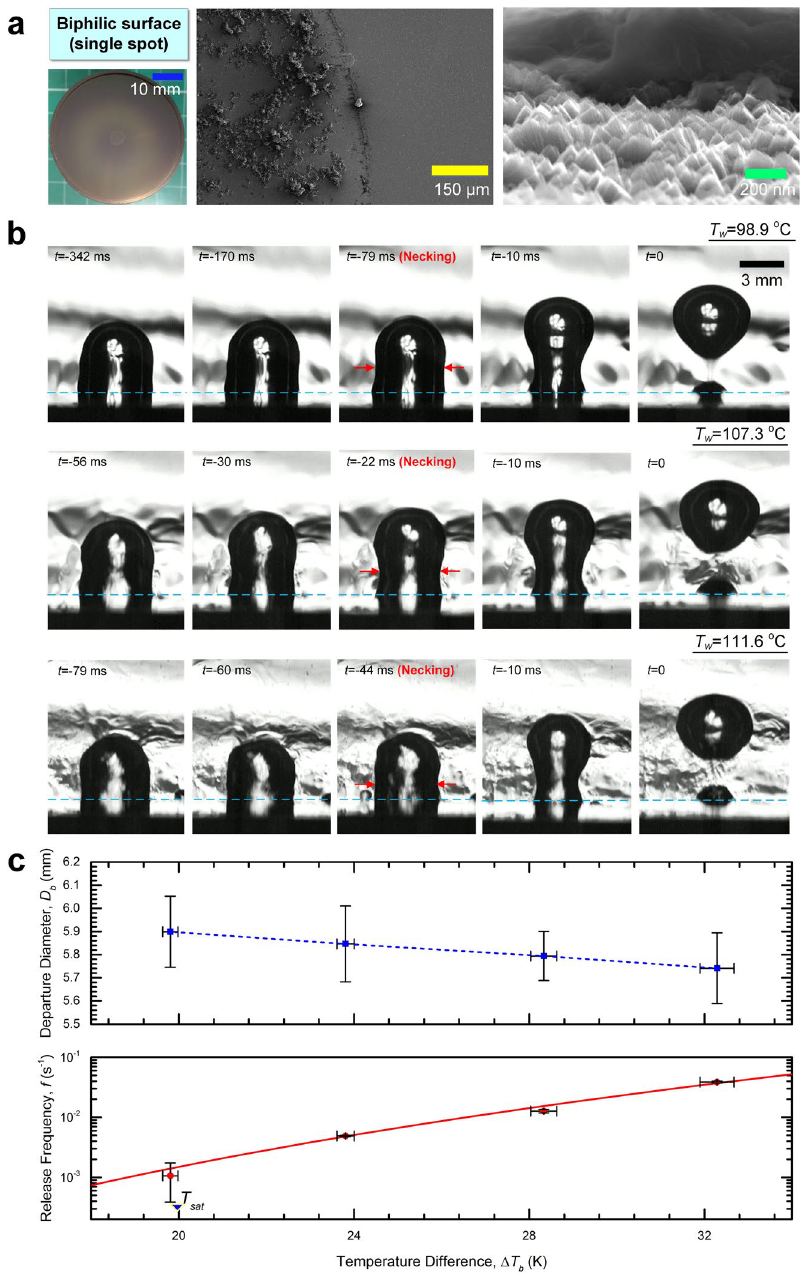
Figure 3. Bubble behaviour in the open system. ( a ) A heterogeneous surface with a single artificial nucleation site. On the superhydrophilic TiO 2 surface ( θ e ≈ 0°, post UV-irradiation) was deposited by drop-coating a hydrophobic island ( θ e > 145°) with a diameter of 6 mm that was composed of APTES (3-aminopropyltriethoxysilane)-modified halloysite nanotubes and synthesized polymer P(FA-C 8 - co - DOPAm). The SEM images confirms dissimilar topography for the non-wetting surface, which was particularly favourable to bubble nucleation. An isolated bubble could preferentially form and grow without interference from neighbouring bubbles. ( b ) Series of high-speed photos showing the process of bubble pinch-off from the biphilic surface at various surface temperatures. The time sequence was set to 0 at the moment of bubble pinch- off. Regardless of the surface temperature, the bubble departure commenced with “necking”. Further stretching of the bubble stem ultimately led to rupture of the interface (with only part of the bubble detached from the surface). The light blue dash line represents the boiling surface. ( c ) Plot of the bubble departure diameter (taken as the equilibrium bubble size before necking), D b , and the release frequency, f , versus the excess surface temperature relative to the bulk temperature, Δ T b , based on the analysis of the high-speed imaging results. The bubble dynamics on the biphilic surface cannot be adequately explained by the existing correlations as the observed partial bubble departures involve essentially no waiting time. The red line represents a best fit to the data, f ~ Δ T b 6.70 ± 0.35 . Each data point in the figure is averaged over five consecutive bubble growth periods, with the error bars indicating the spread of the individual